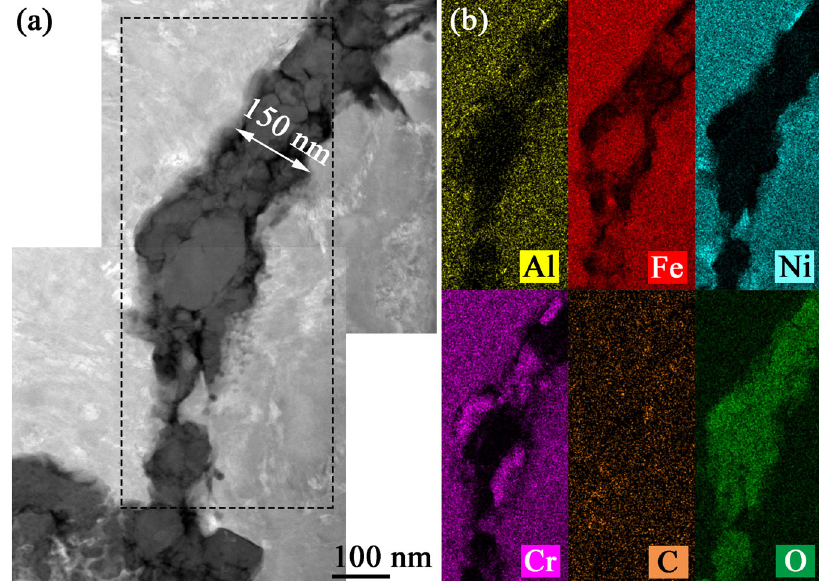
Fig. 13 TEM results of the crack path inside the green frame in Fig. 12a. a HAADF image, b EDS mapping of ( a